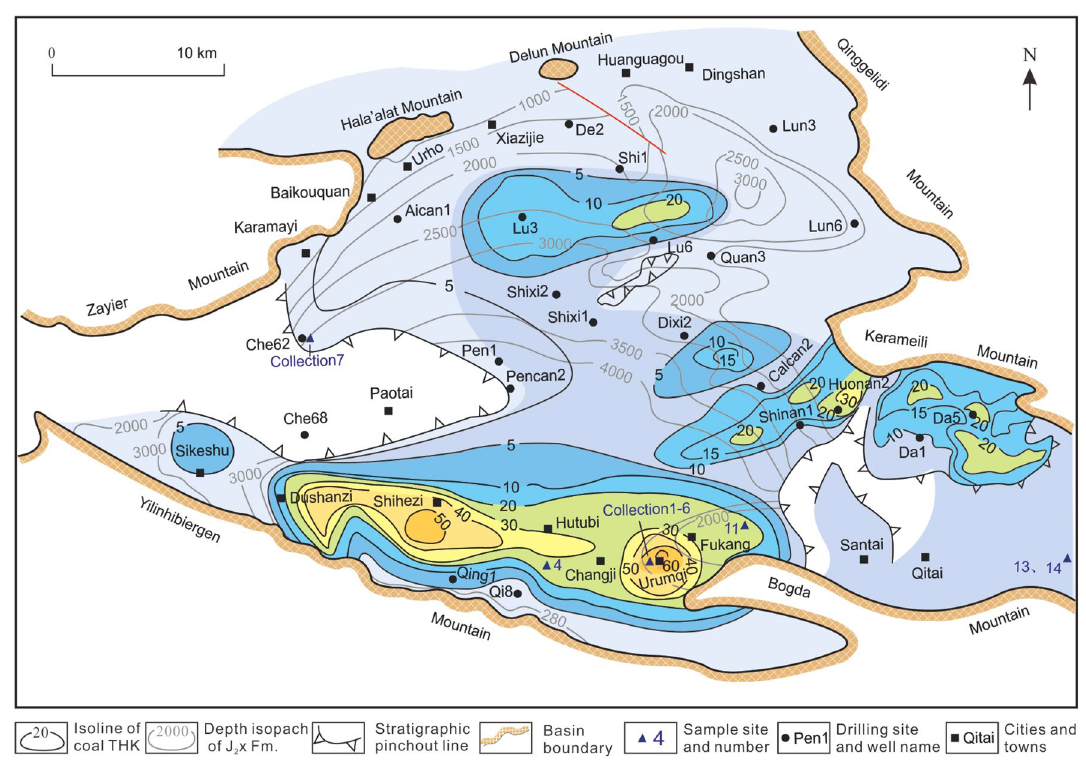
Fig. 4 Contour of thickness and buried depth of Xishanyao Fm. coal reservoir in Junggar Basin (Unit in